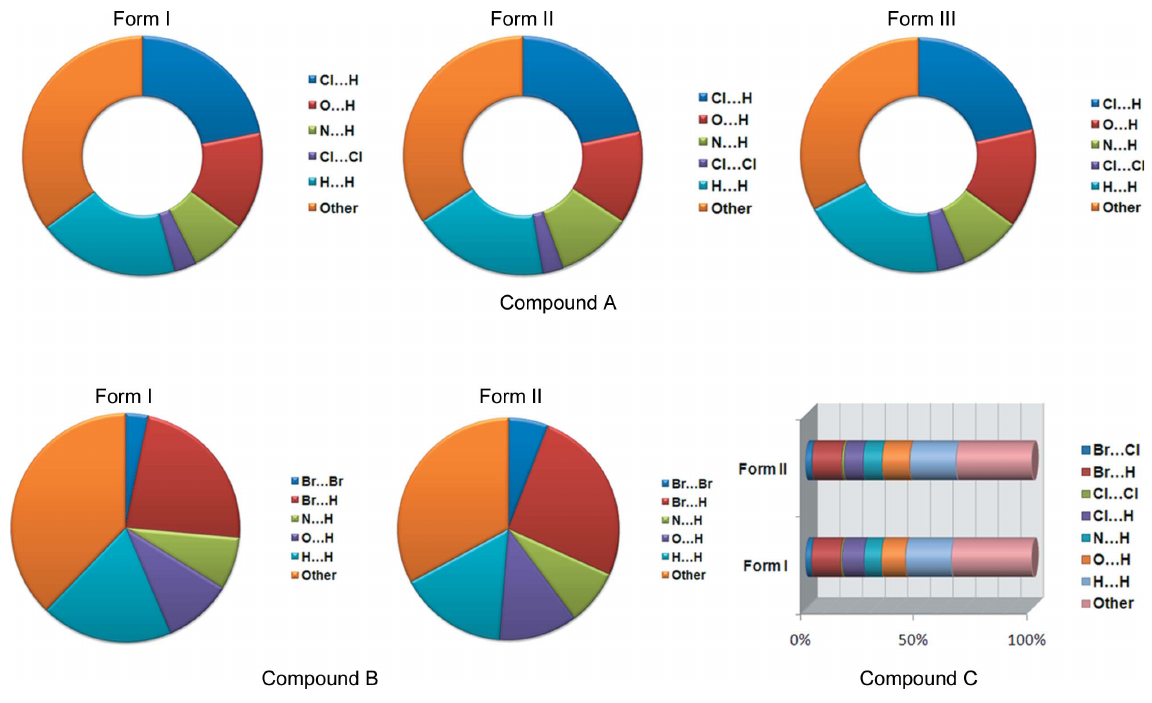
Figure 14 Hirshfeld surface analysis for polymorphs of Compounds-A, -B and -C, showing the contributions of the different hydrogen- and halogen-bonding